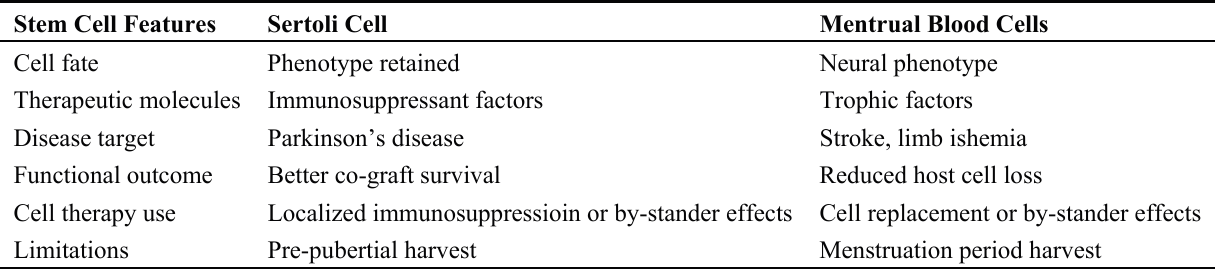
Table 1. A vis-à-vis comparison of gender-specific